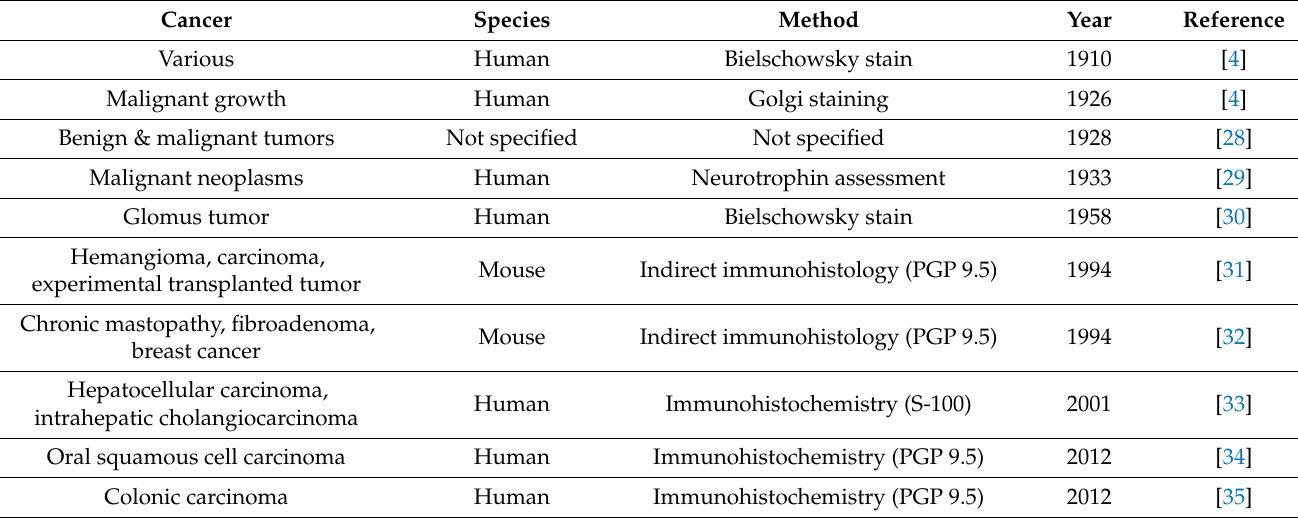
Table 2. Observations of no tumor